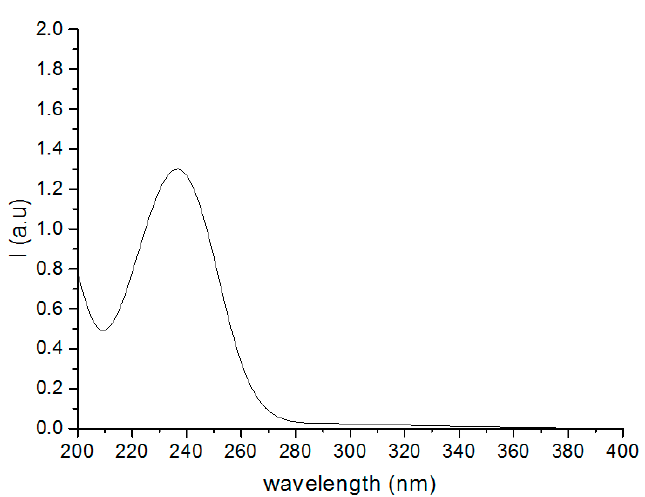
Figure A1. UV absorption spectra of 0.94 μ L LG essential oil in 3 mL of acetonitrile.